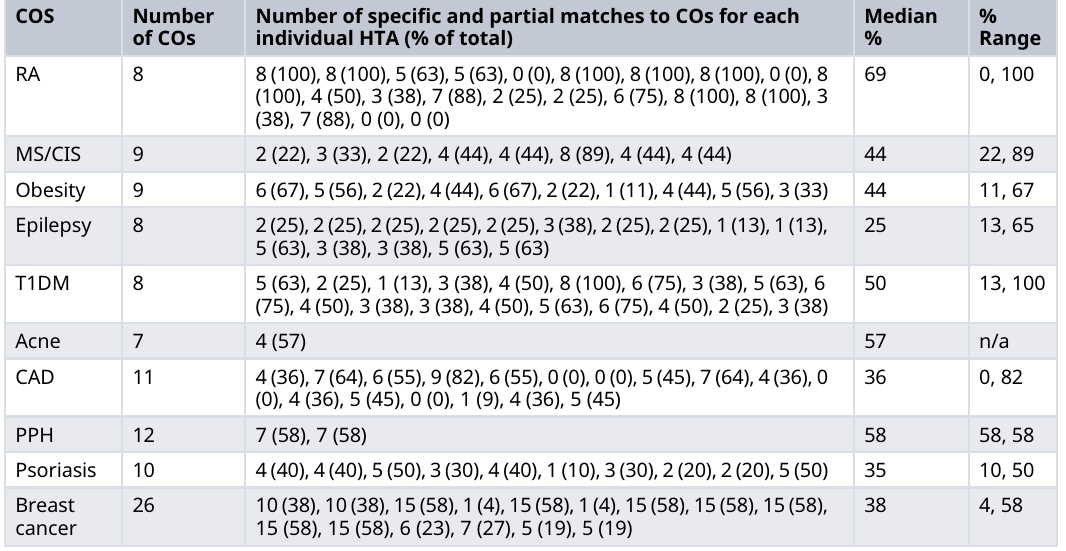
Table 4. Number of HTA outcomes with partial or specific match to core outcomes.